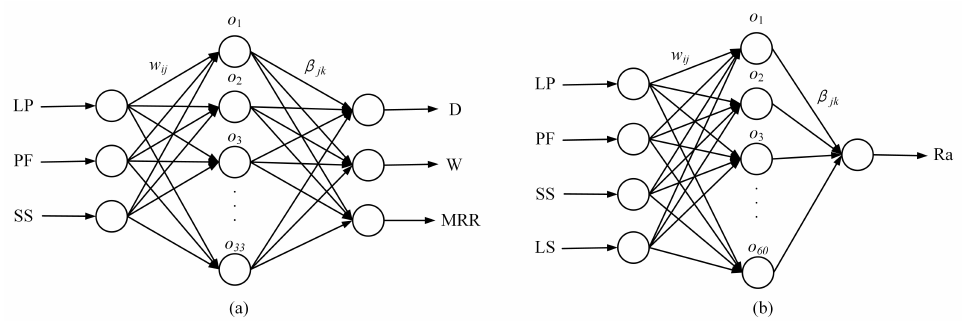
Figure 6. Prediction models for surface features based on ELM. ( a ) ELMSS model for feature predic- tion. ( b ) ELMPS model for feature prediction.